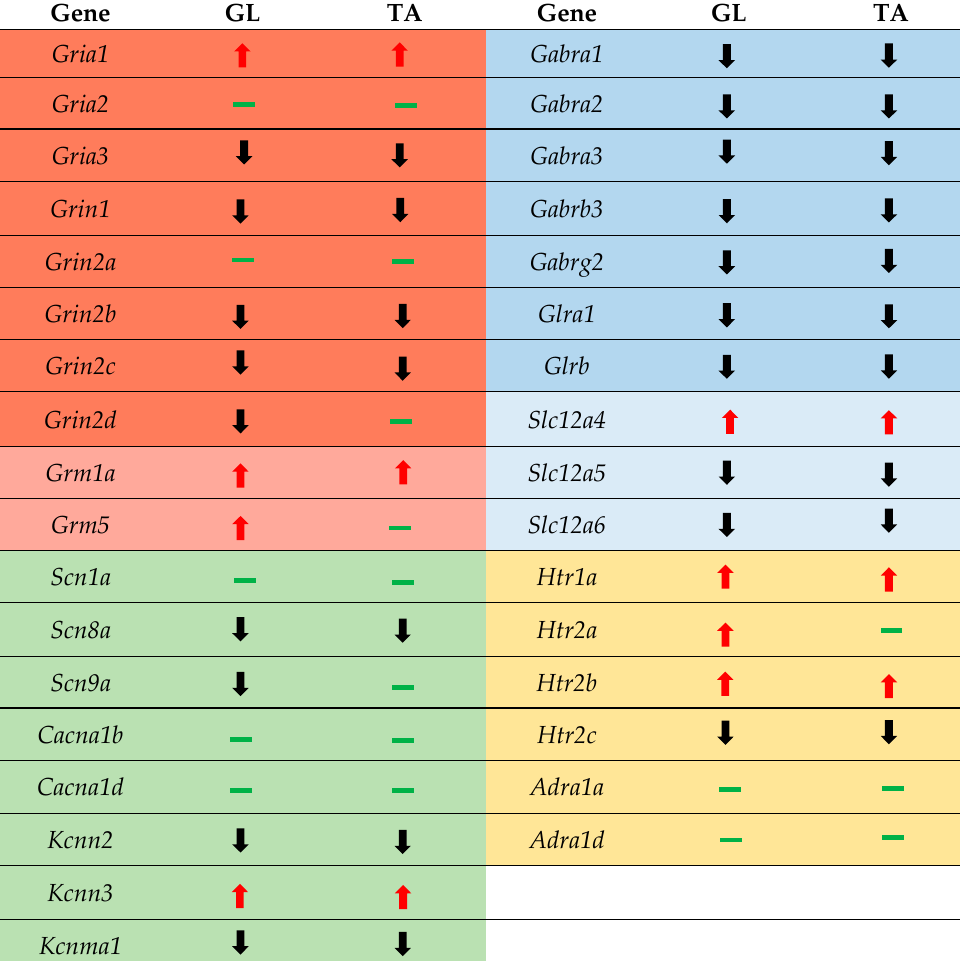
Table 1. Direction of changes in gene expression in GL and TA MNs at 2 weeks after SCT. Gene GL